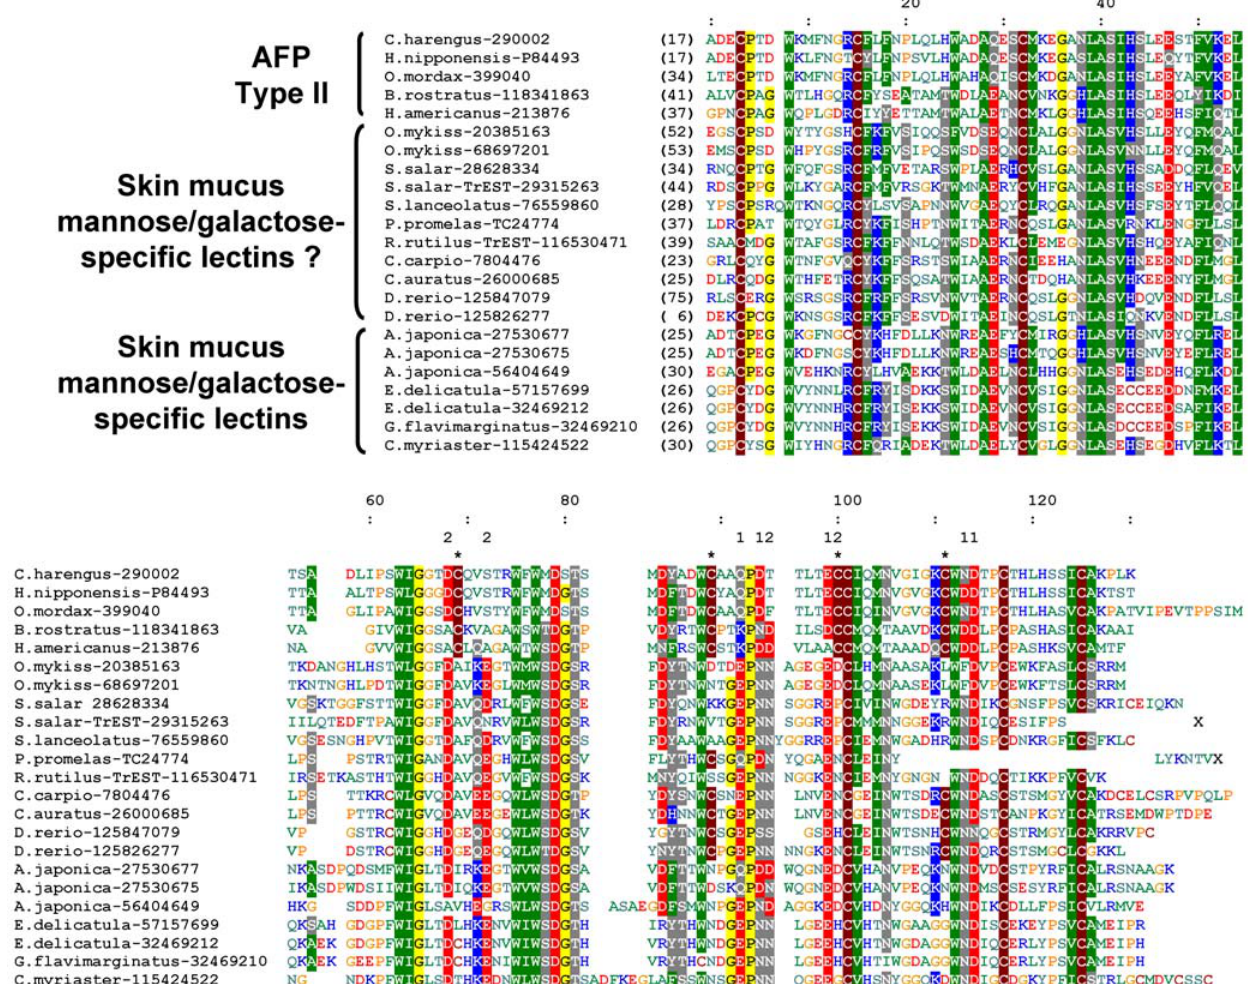
Figure 2. Sequence alignment of type II AFPs and most closely related fish-specific lectins. Similar or identical amino acid residues are highlighted. Residues are colored according to their physicochemical properties. Numbering in the top ruler corresponds to residue numbering of hAFP. Numbers in brackets in the N- and C-terminal part of the alignment indicate how many amino acids have been omitted for the sake of the clarity. Type II AFPs– specific cysteines forming disulfide bonds are indicated by ‘‘*’’. Residues forming the first Ca 2 + -binding site in hAFP are indicated with ‘‘1’’. Residues homologous to residues of the second Ca 2 + -binding site are indicated as ‘‘2’’.